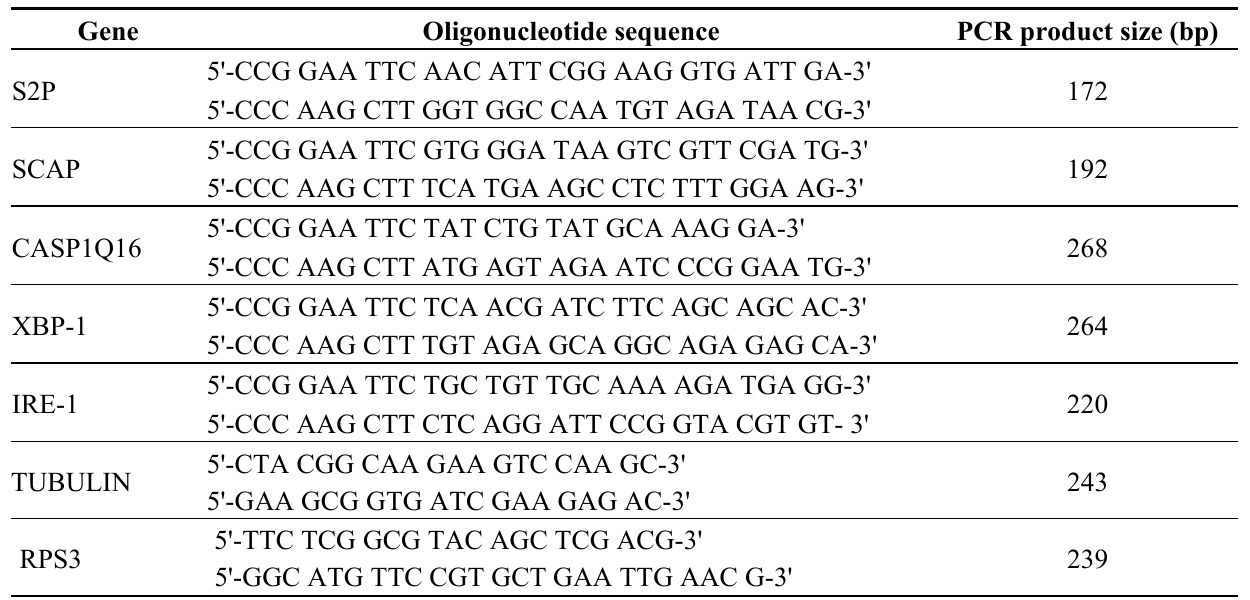
Table 3. Sequence of